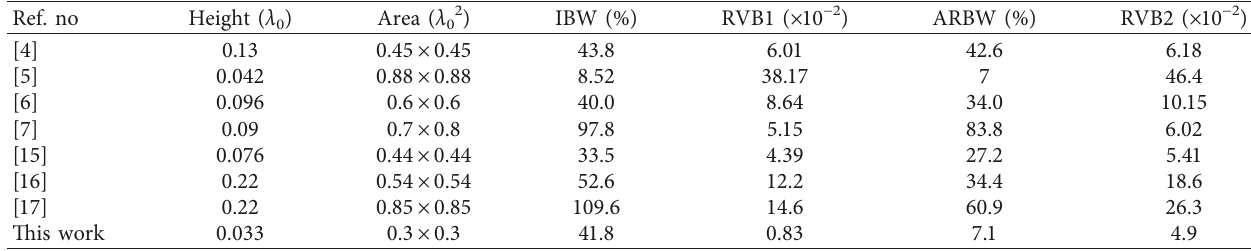
Table 2: Comparison of the antenna size and performance between this work and other recently published works. Ref. no Height ( λ 0